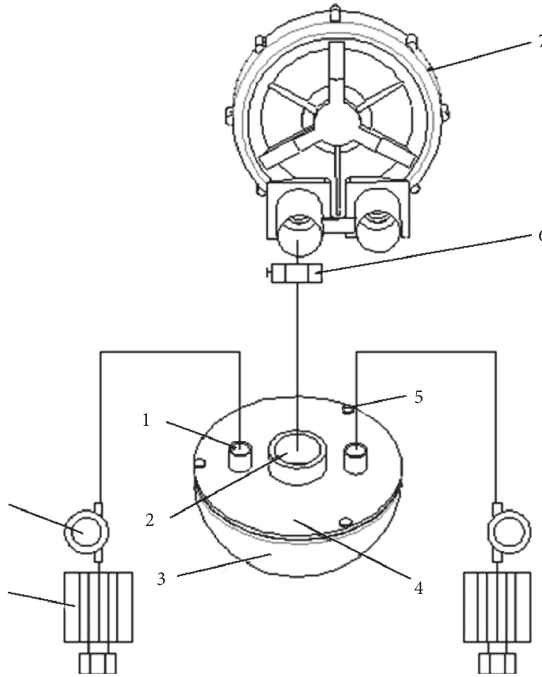
Figure 10: Schematic diagram of seed clearing system. 1. Seed meter connection tube. 2. Waste seed room vacuum tube. 3. Waste seed storage room. 4. Waste seed room cover. 5. Bolt. 6. Switch device. 7. Vacuum fan. 8. Air pump. 9. Storage seed shell.